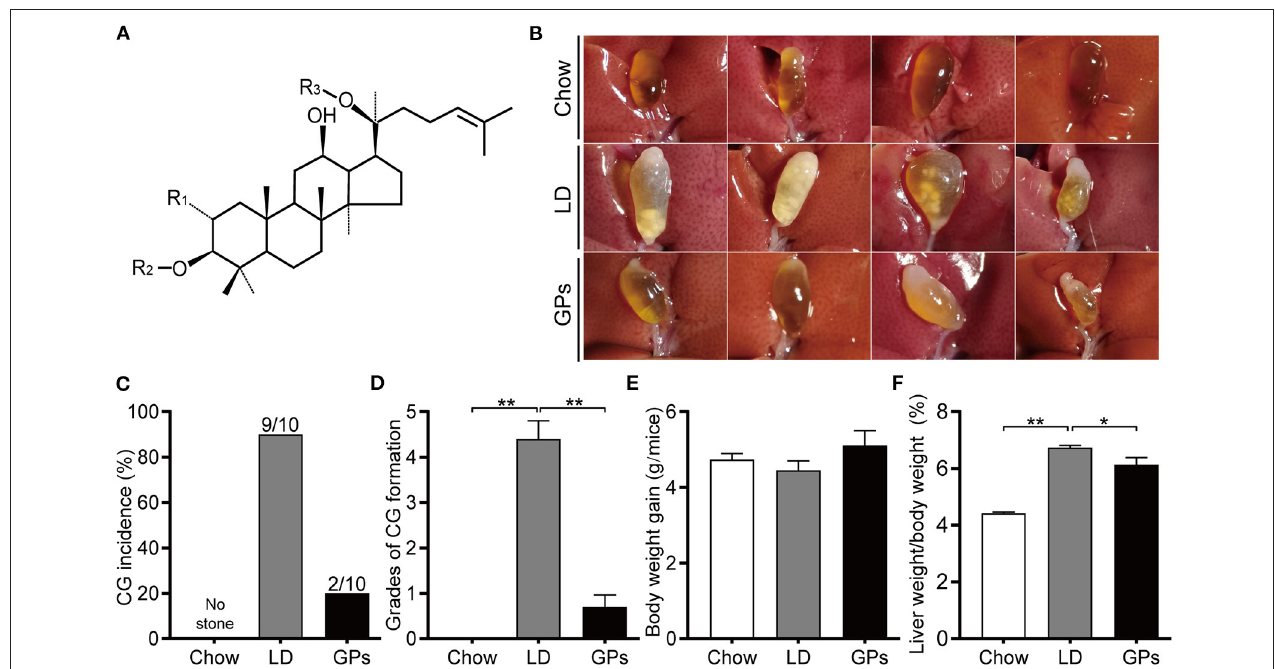
FIGURE 1 | Effects of Gypenosides (GPs) on the prevention of cholesterol gallstones (CGs). (A) General structure of dammarane-type GPs. R1/R2 = glucose, rhamnose; R3 = glucose, xylose. (B) Representative gallbladders in each group. (C) CG incidence. (D) Grades of CG formation. (E) Body weight gain. (F) Ratio of liver weight-to-bodyweight. Data are reported as means ± SEM ( n = 10). * P < 0.05, ** P <